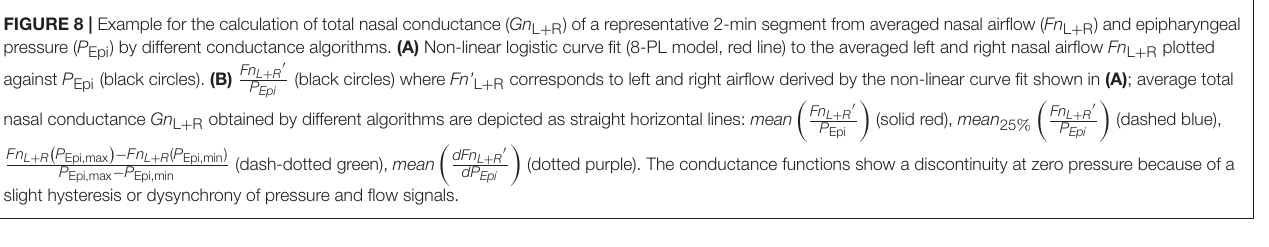
R ) and epipharyngeal + R plotted + Fn L + R ′ P Epi (cid:19) (dashed blue),